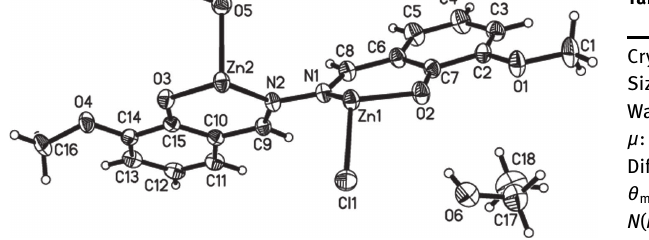
Table 1: Data collection and handling.